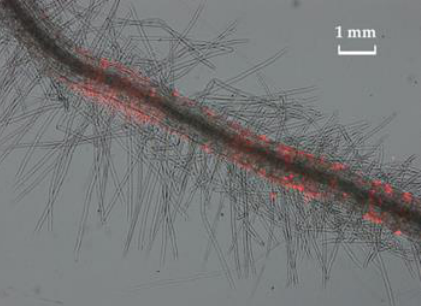
Figure 6. Bacteria transformed with the pJNTurboRFP vector on the surface of pea plant root hairs.